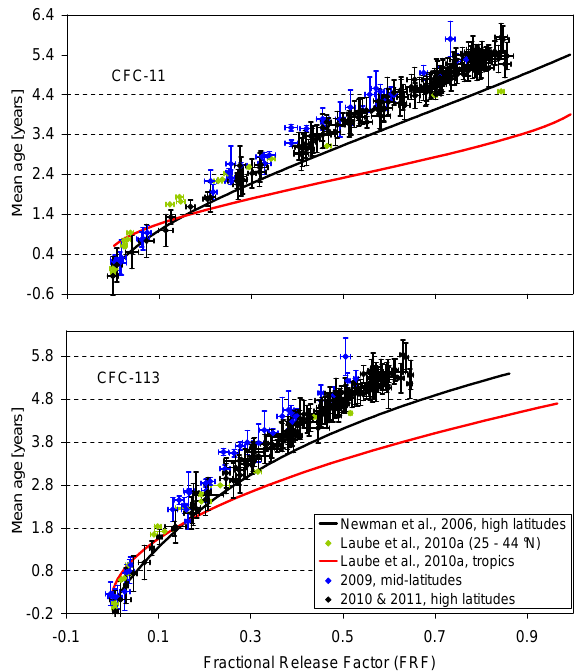
Figure 3. Correlation of Fractional Release Factors (FRFs) with mean age of air for CFC-11 3 Fig. 3. Correlation of fractional release factors with mean age of and CFC-113. High (black) and mid-latitude (blue) data from this study are shown alongside 4 air for CFC-11 and CFC-113. High- (black) and mid-latitude (blue) with tropical and extra-tropical data from Laube et al. (2010a) (FRFs from 2005 and 2006) as 5 data from this study are shown alongside with tropical and extra- well as high latitude correlations from Newman et al. (2006) (data from 2000). The error bars 6 tropical data from Laube et al. (2010a) (FRFs from 2005 and 2006), were derived using the 1 σ measurement uncertainty (or its equivalent in mean age). To 7 as well as high-latitude correlations from Newman et al. (2006) account for the uncertainty in entrance mixing ratios we also added the percentage difference 8 (data from 2000). The error bars were derived using the 1 σ mea- between the NOAA-ESRL stations in Tutuila, American Samoa (14.25° S, 170.56° W) and 9 surement uncertainty (or its equivalent in mean age). To account for the uncertainty in entrance mixing ratios, we also added the percent- Mauna Loa, Hawaii, United States (9.54° N, 155.58° W) as well as the respective NOAA 1 σ 10 age difference between the NOAA-ESRL stations in Tutuila, Amer- measurement uncertainties both averaged over 2010. For samples for which mean age was 11 ican Samoa (14.25 ◦ S, 170.56 ◦ W), and Mauna Loa, Hawaii, United derived from a correlation with CFC-12 (see text) we added an additional error of 0.06 years 12 States (9.54 ◦ N, 155.58 ◦ W), as well as the respective NOAA 1 σ from the uncertainty of this correlation. 13 measurement uncertainties, both averaged over 2010. For samples for which mean age was derived from a correlation with CFC-12 (see text), we added an additional error of 0.06 years from the un- certainty of this